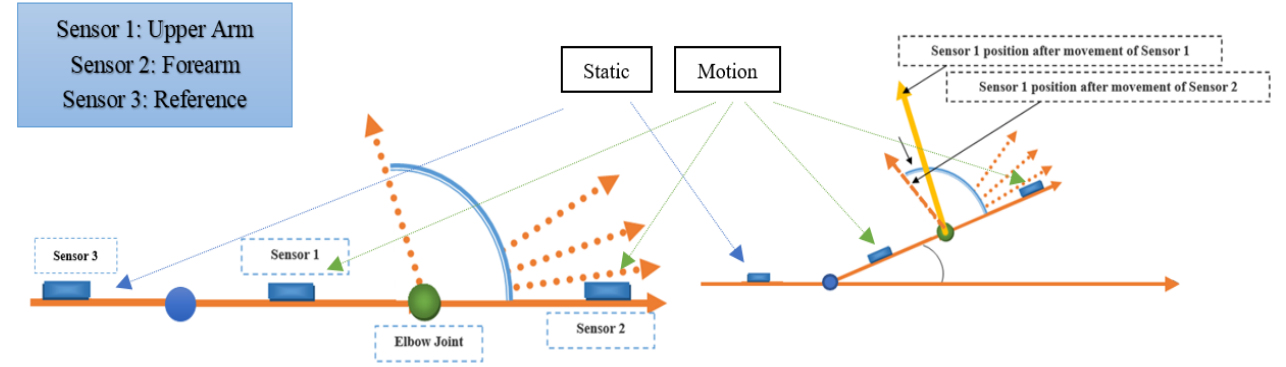
Figure 5. Joint angle (three sensors).